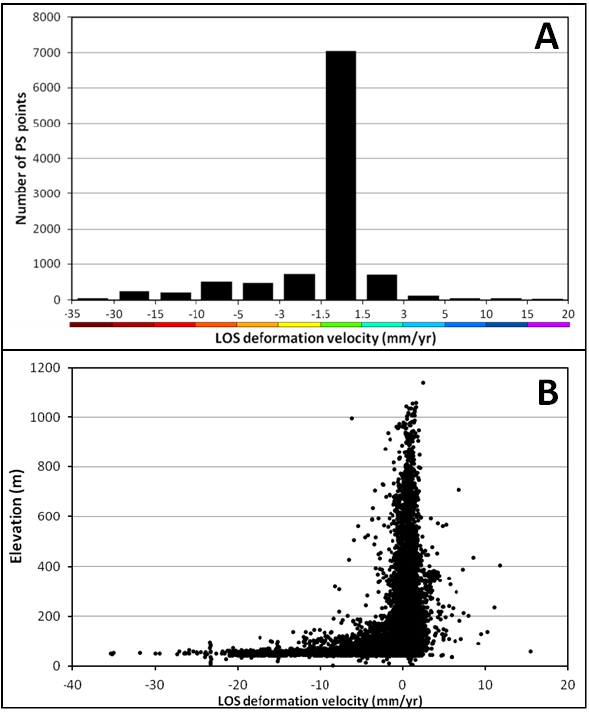
Figure 5. Histogram of LOS deformation velocities distribution in the Anthemountas basin (A). Comparison between LOS deformation velocities with relative elevation for the dataset of PS points (B).